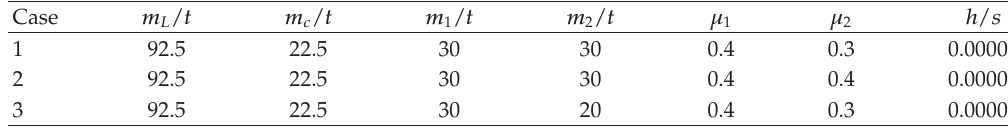
Table 1: Numerical model parameters.